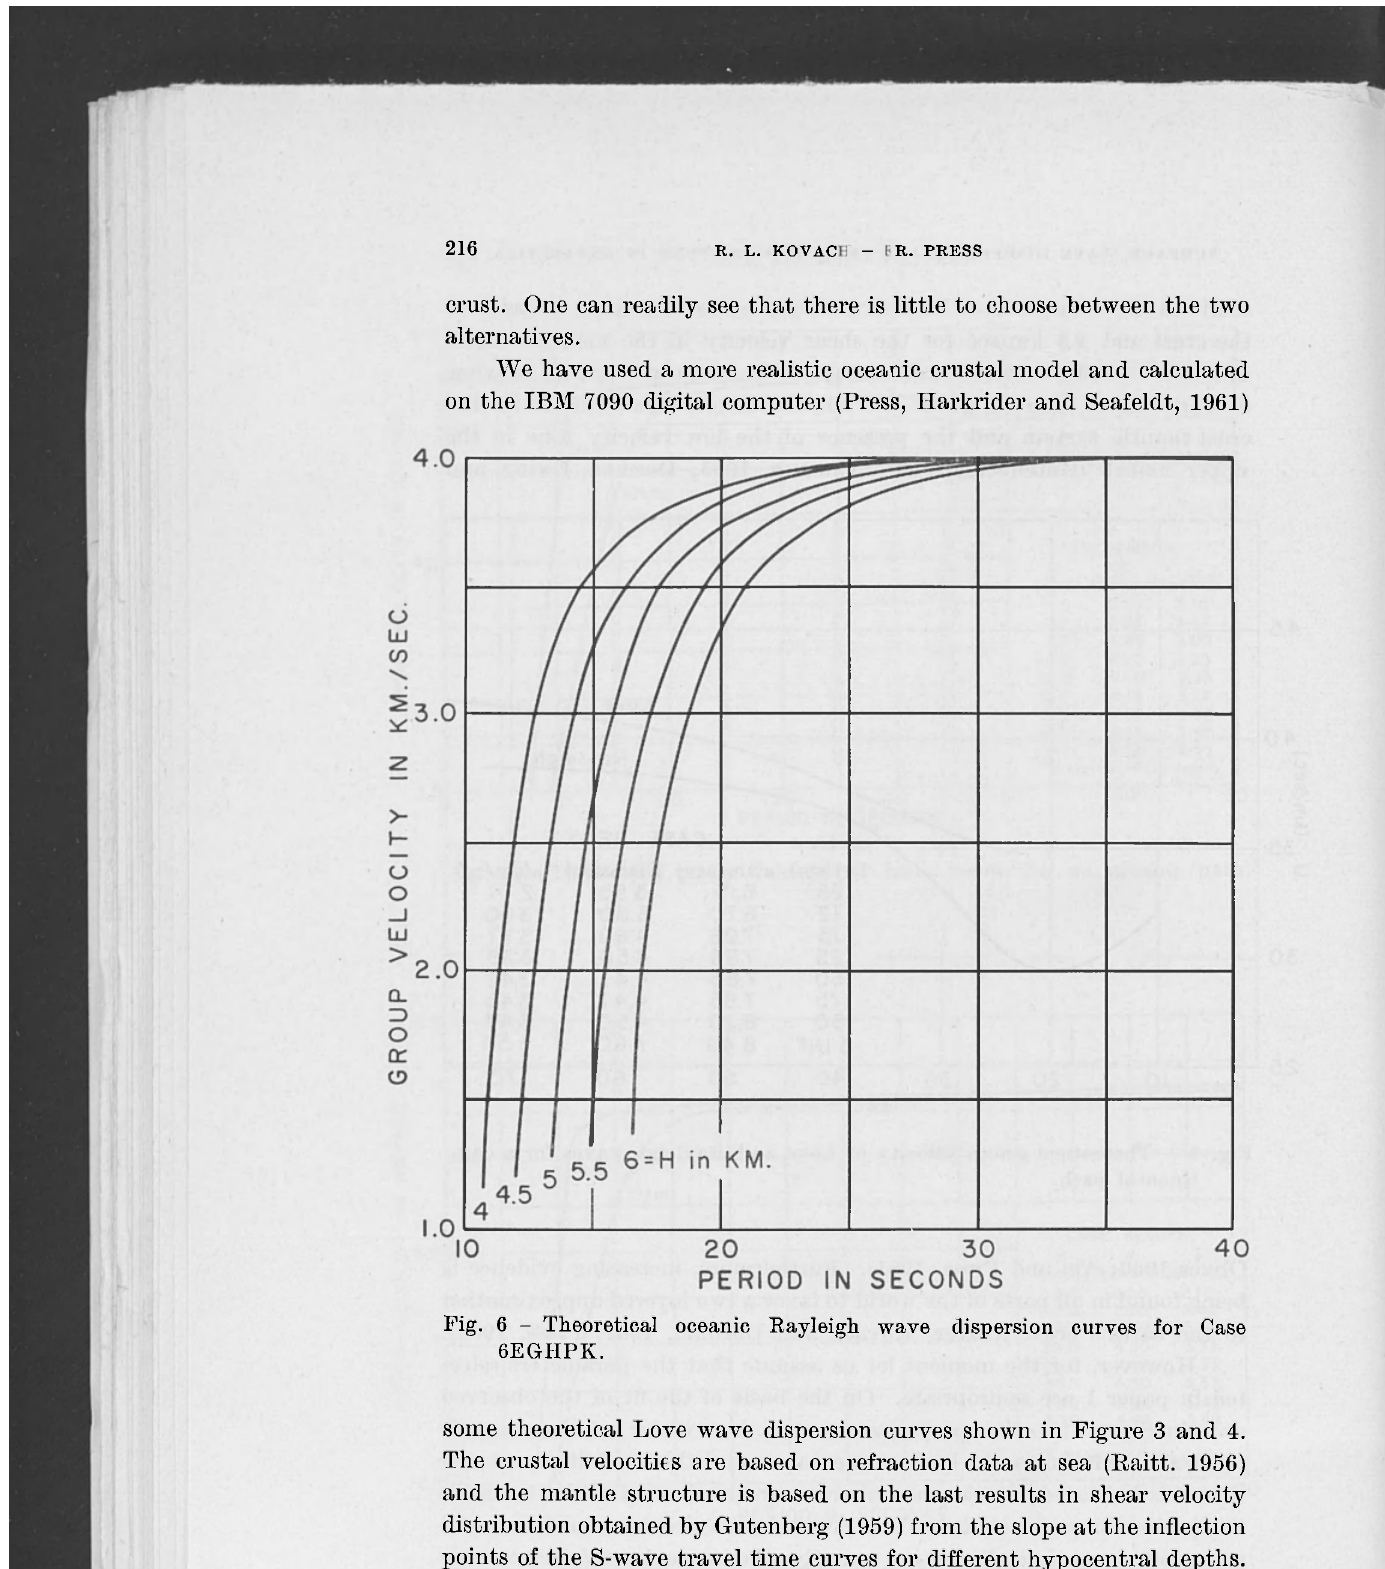
Fig. 6 - Theoretical oceanic Rayleigh wave dispersion curves for Case